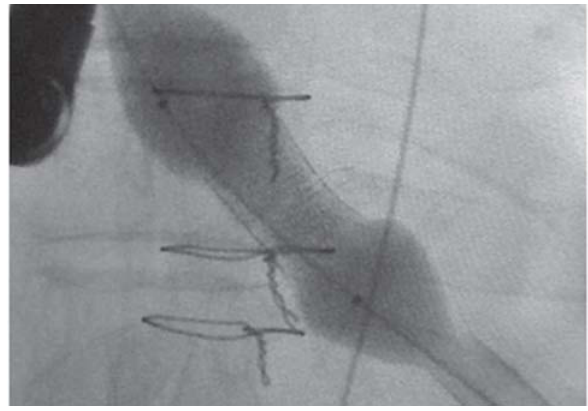
Fig. 3 - Insuflação do cateter-balão e abertura da prótese. Fluoroscopia